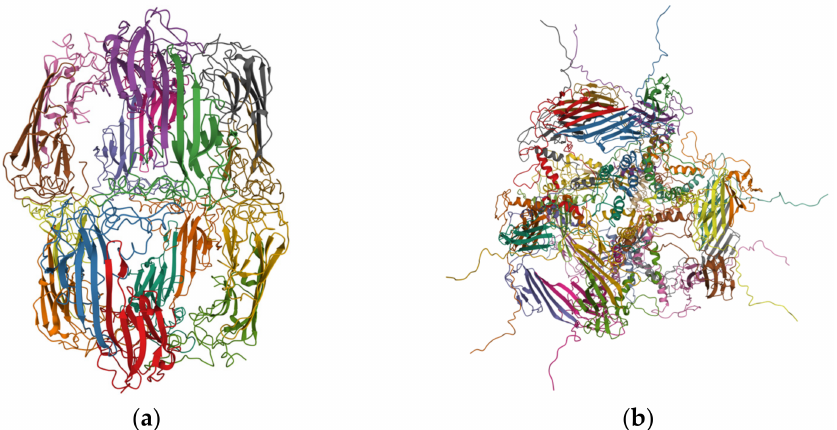
Figure 1. ( a ) Pseudo-atomic model of recombinant human α A-crystallin (reduced) 16-mer assembly. Image from the RCSB PDB (rcsb.org, accessed on: 8 April 2021) of PDB ID 6T1R [20] created with Mol* [28]. ( b ) Pseudo-atomic model of recombinant human α B-crystallin 24-mer assembly. Image from the RCSB PDB (rcsb.org, accessed on: 8 April 2021) of PDB ID 3J07 [21] created with Mol*